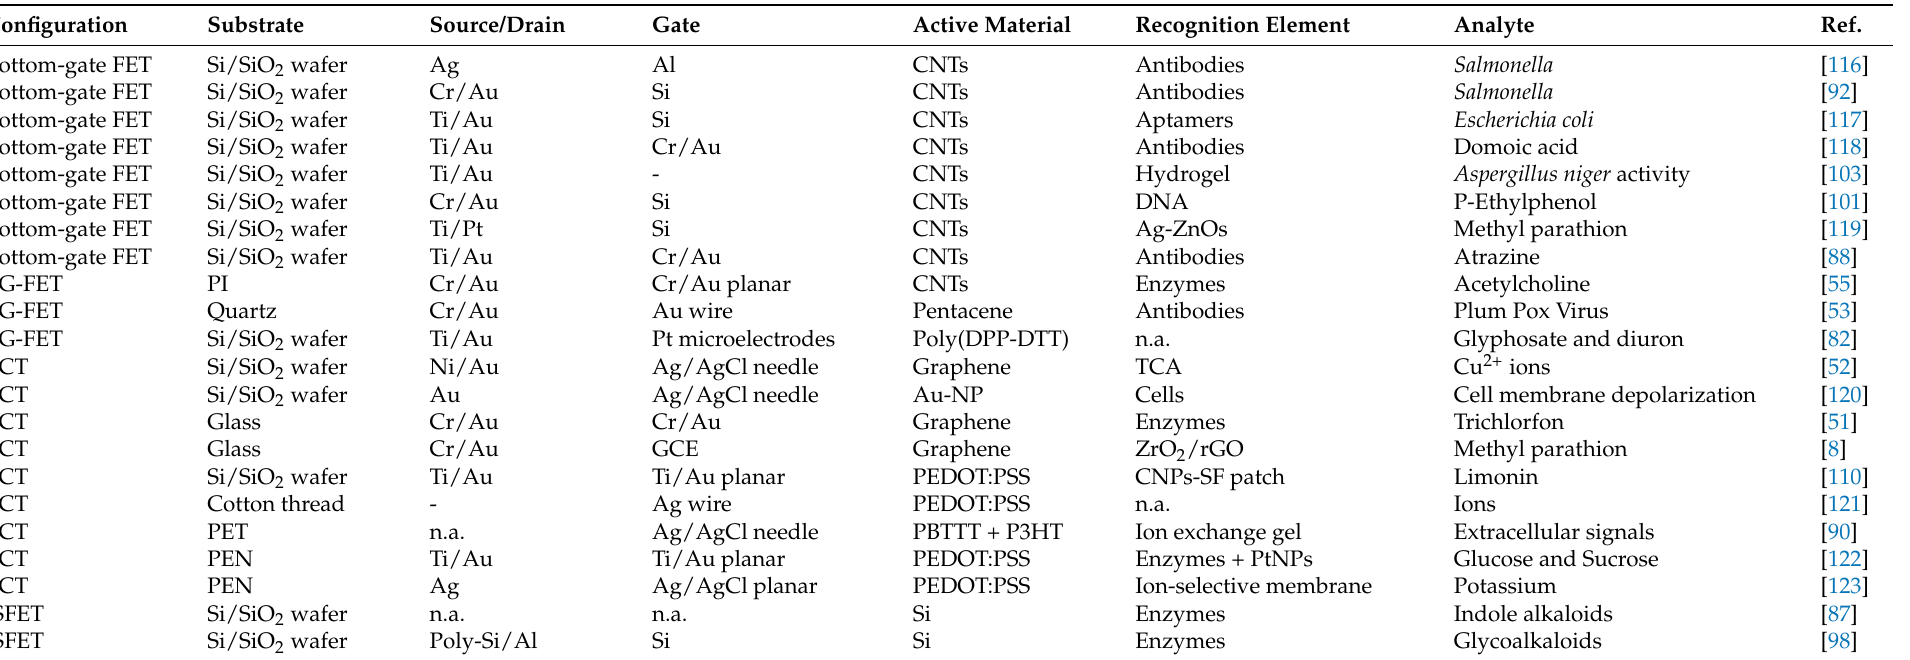
Table 1. Summary of the different device configurations and materials (substrate, source/drain electrodes, gate electrodes, active material) used in the realization of bio-FETs for environmental and agricultural plant monitoring. The analyte of interest and recognition elements used by authors are also